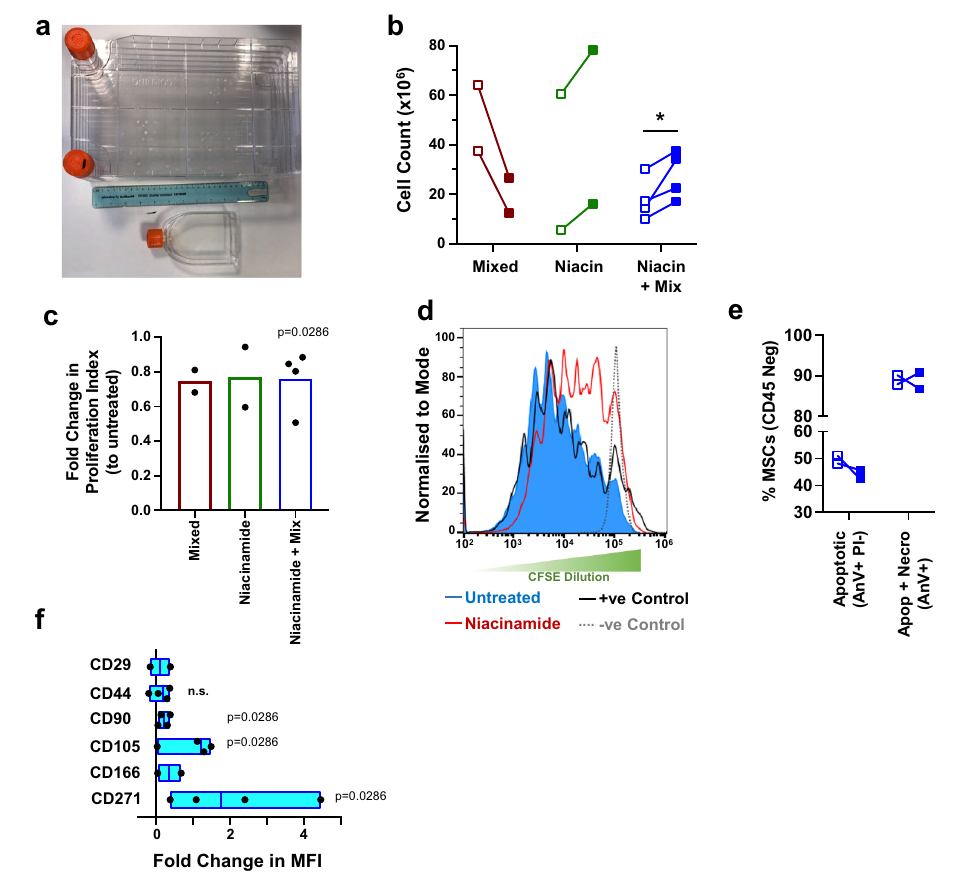
Fig. 6 | Upscaling cell cultures using metabolite treatment supports produc- tionofimmunosuppressiveMSCs.a Stro-1+MSCsweregrownusing fi ve-layercell stacks to increase cell yields (3180 cm 2 growth area, shown next to a standard T75 fl ask). b Numbersofcellsrecovered from the cellstacks after two weeksof culture with ( fi lled square) and without (empty square) metabolite treatment. Treatments were mixed (adenine, niacinamide, L-glutamic acid and citrate), niacinamide only (niacin) and niacinamide followed by mixed. c MSCs grown in large culture con- ditions were harvested, replated and their immunosuppressive capacity measured co-culturedwithCFSE-labelled,IL-2andPHAstimulatedPBMCsforafurther5days. Proliferationwasassessedby fl owcytometry.Foldchangeintheproliferationindex to matched untreated controls shown for each metabolite treatment. d Representative fl ow cytometry histogram of CFSE dilution in T cells co-cultured with niacinamideand mixed treated MSCs for5days. e Stro-1 + MSCs werecultured with niacinamide followed by the four metabolite mixture and assessed for